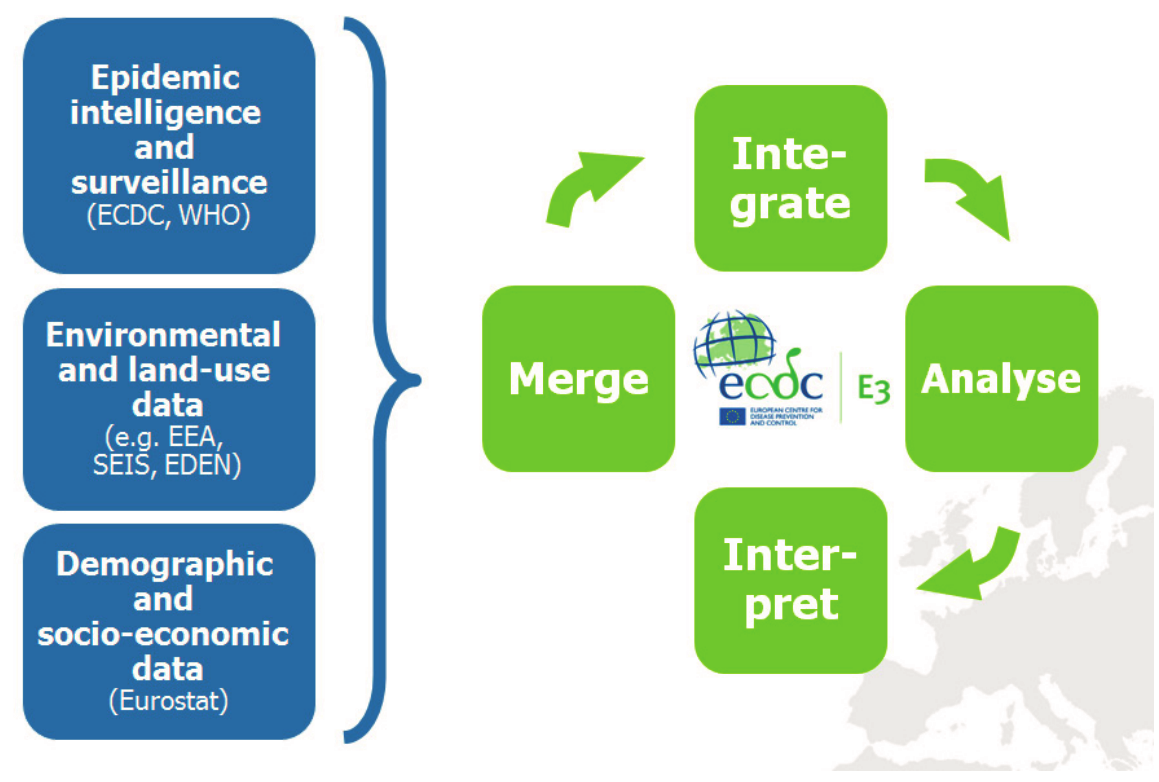
Figure 3. The concept of the European environment and epidemiology (E3)